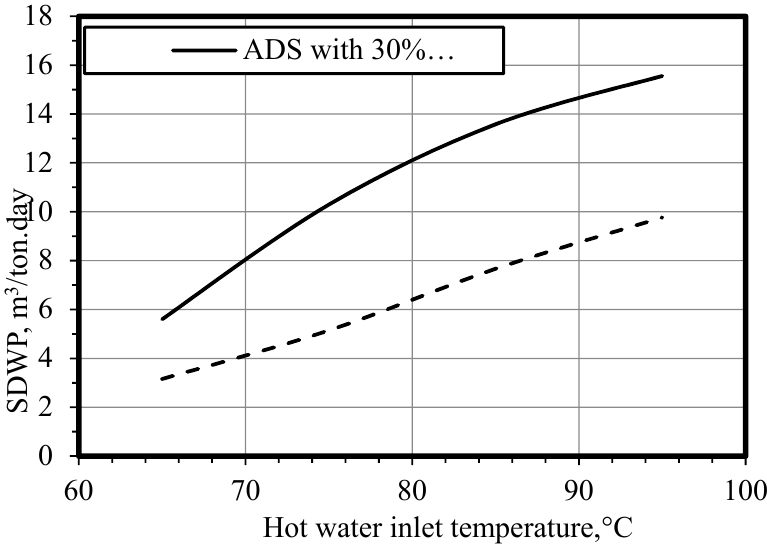
Figure 2. SDWP at different driving temperatures with and without aluminum filings.